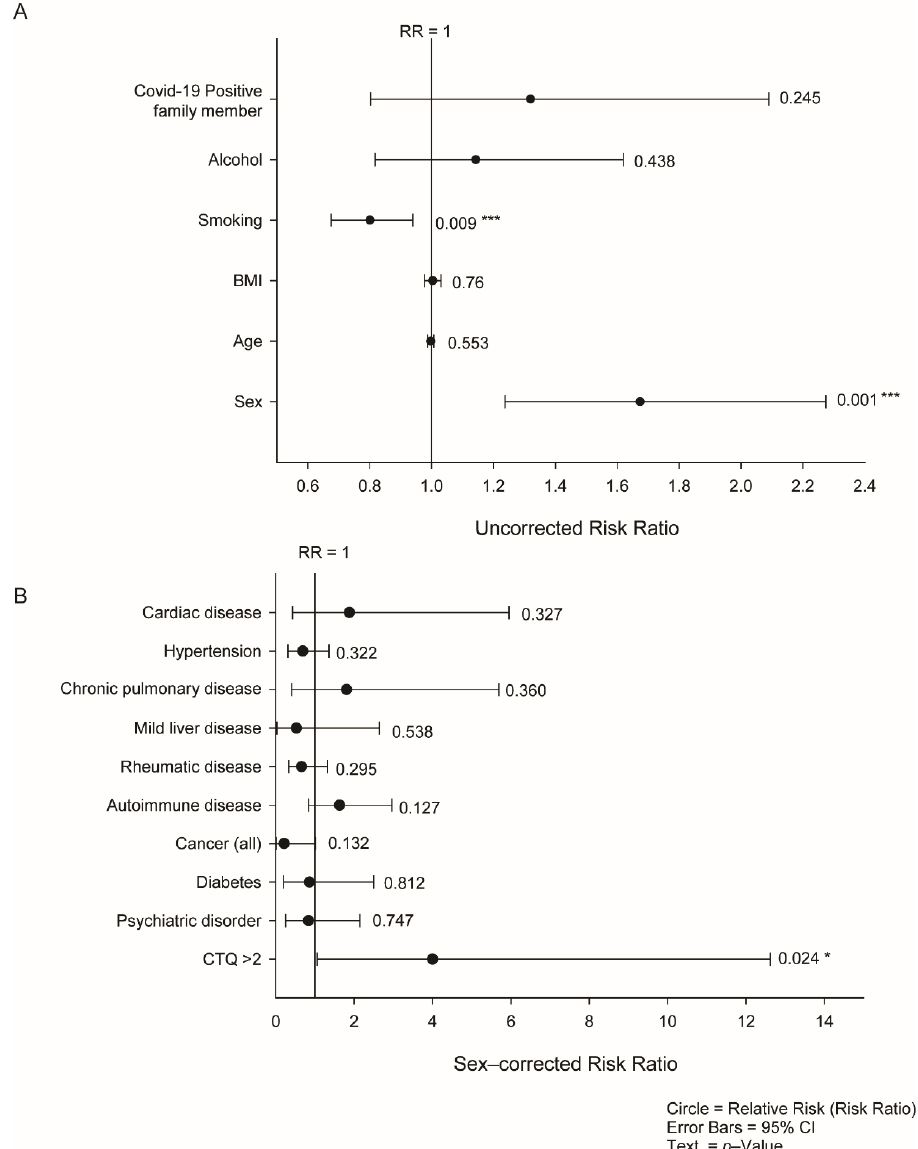
Figure 1. Demographics of SARS-CoV-2 IgA seropositivity in asymptomatic or oligosymptomatic individuals. ( A ) Crude relative risk estimates for SARS-CoV-2 IgA seropositivity for all members of the CON-VINCE cohort finishing the five experimental visits. ( B ) Sex-adjusted logistic regression relative risk of being SARS-CoV-2 IgA seropositive due to pre-existing comorbidities. Both panels: Circles represent the relative risk (RR); error bars: 95% confidence interval; text: p -value. *, p < 0.05; ***, p <